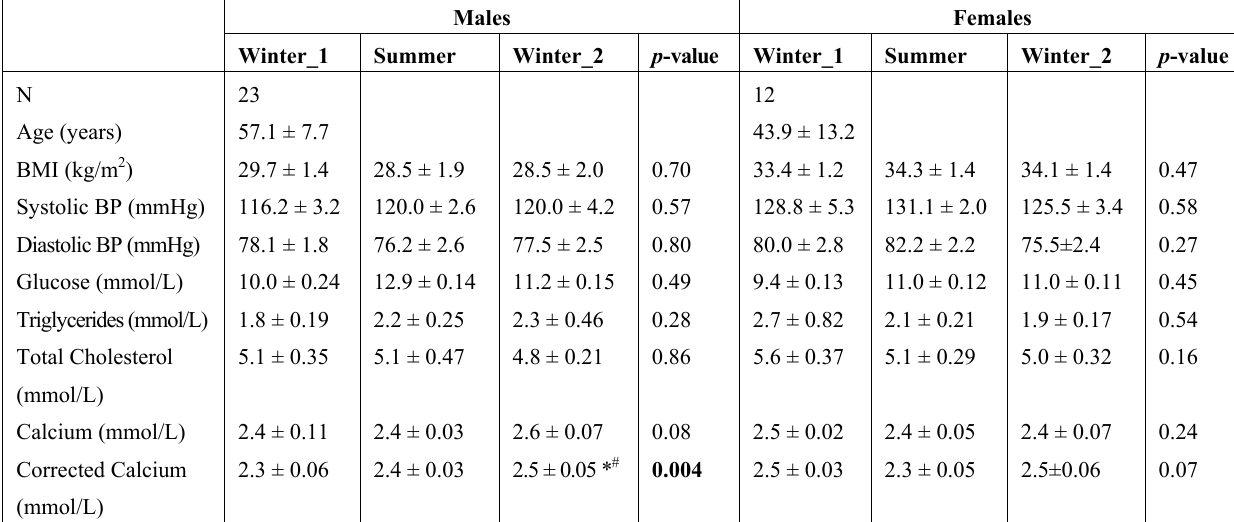
Table 3. Effect of Season on Bone Markers in Males and